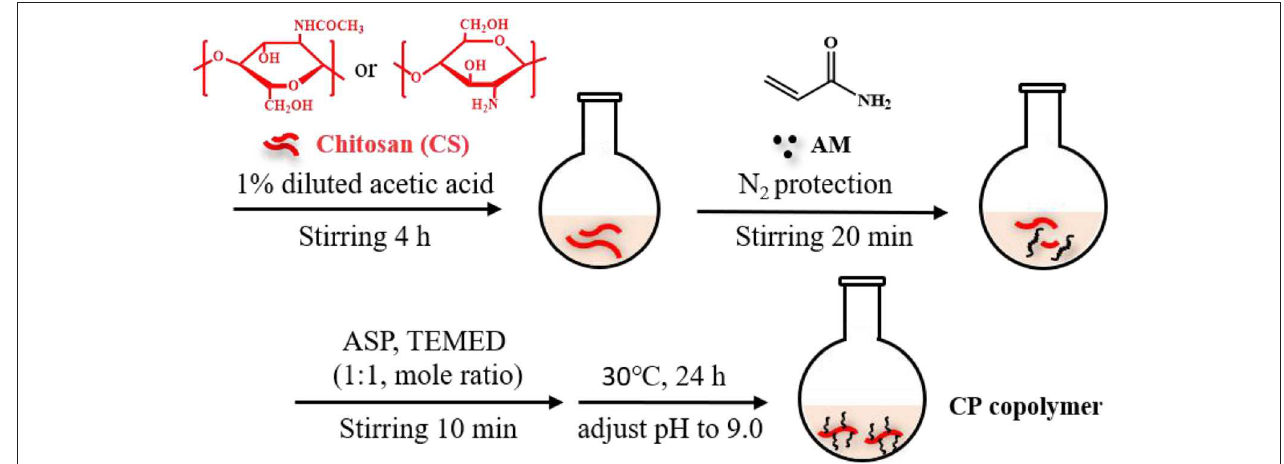
FIGURE 1 | Synthetic scheme of chitosan-based CP copolymer formation by in situ free radical polymerization.